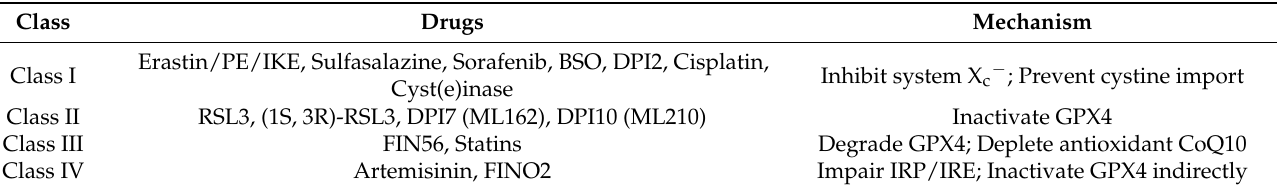
Table 2. Several common ferroptosis inducers and their mechanism of